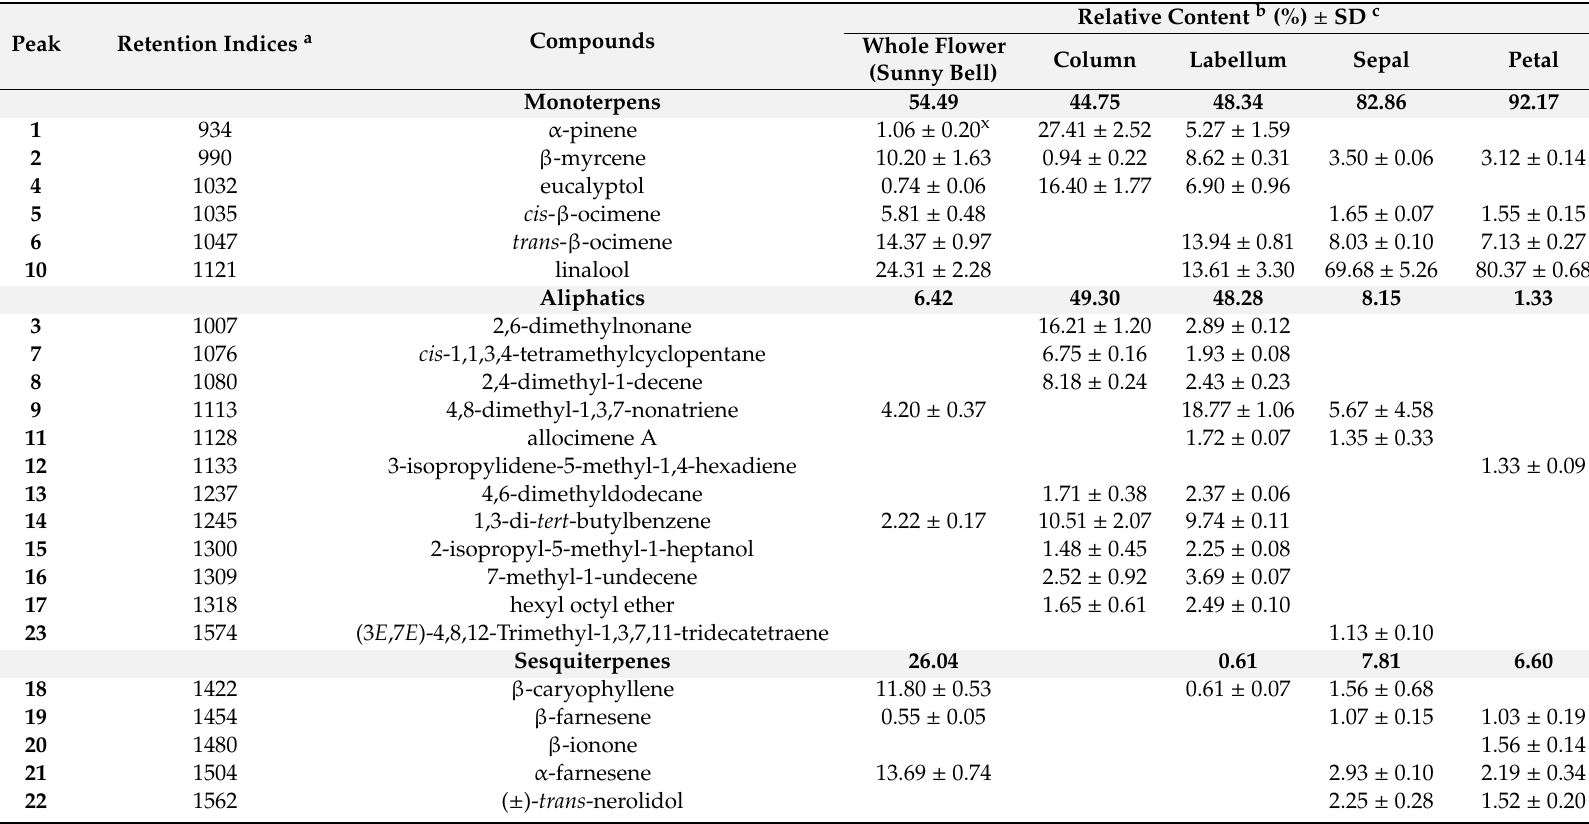
Table 3. Percentage of volatile compounds identified in four di ff erent floral organs of a new hybrid, Cymbidium “Sunny Bell” using HS-SPME-GC-M.